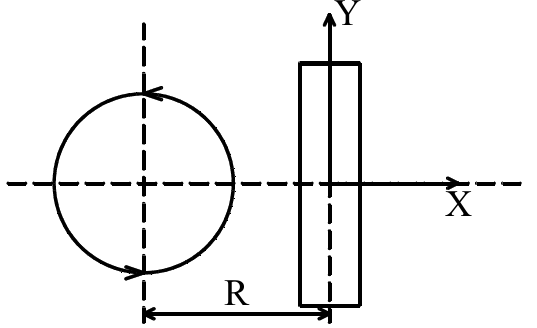
Figure 2. Diagram of the relative positions of the rigid car model and the tornado.